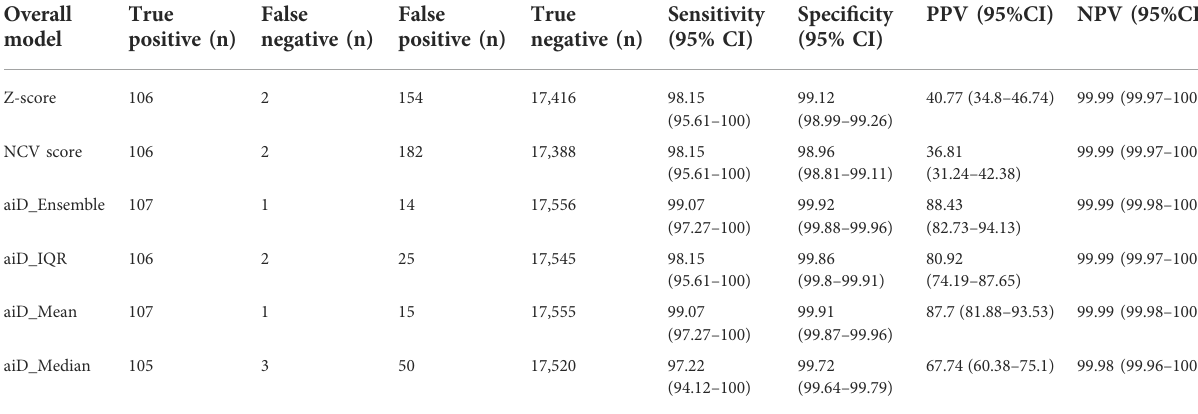
TABLE 1 Overall performance of each algorithm on the clinical dataset. Overall